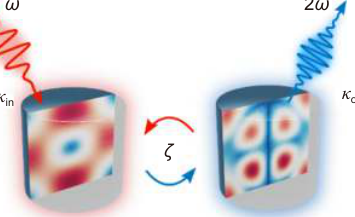
Fig. 1 | Simplified scheme of SHG in a leaky cavity. FF (SH) beam is represented in red (blue), κ in ( κ out ) denotes the input (output) coupling coefficient and the spatial overlap between the dominant modes at the two